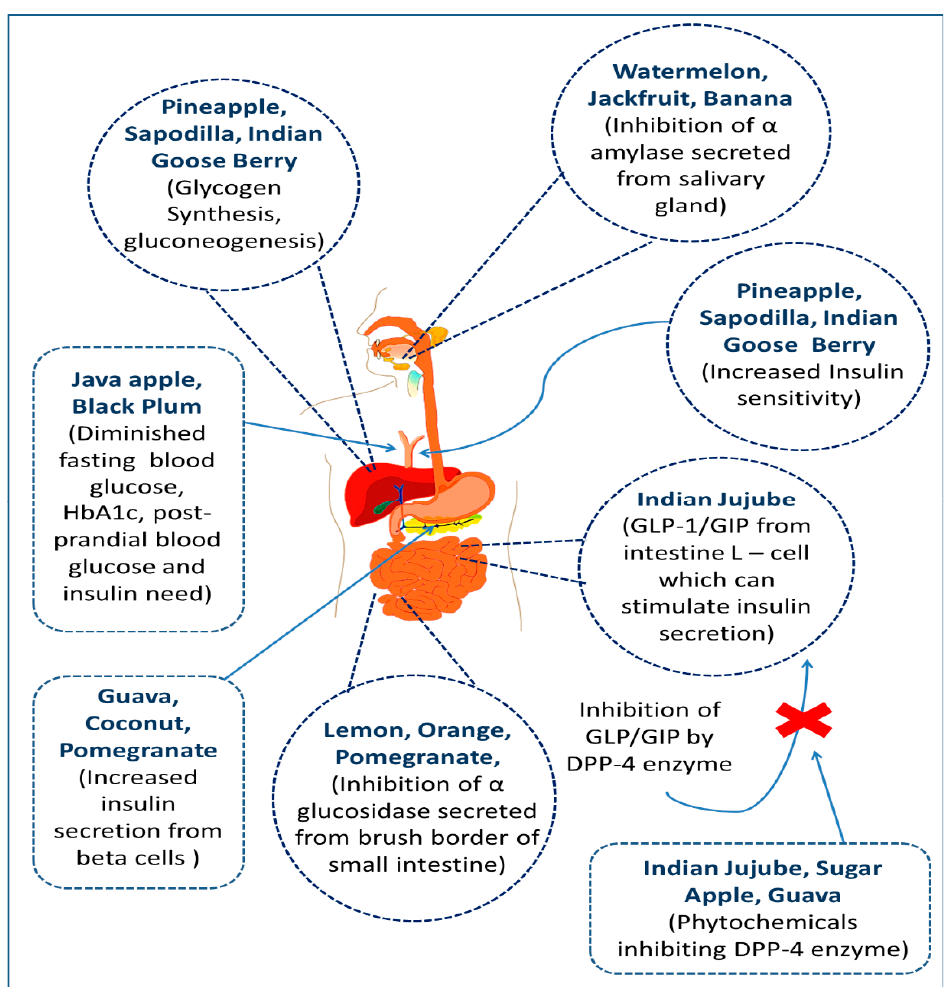
Figure 1. Mechanism of actions of fruit plants and reported phytochemicals to exert antidiabetic potentials.